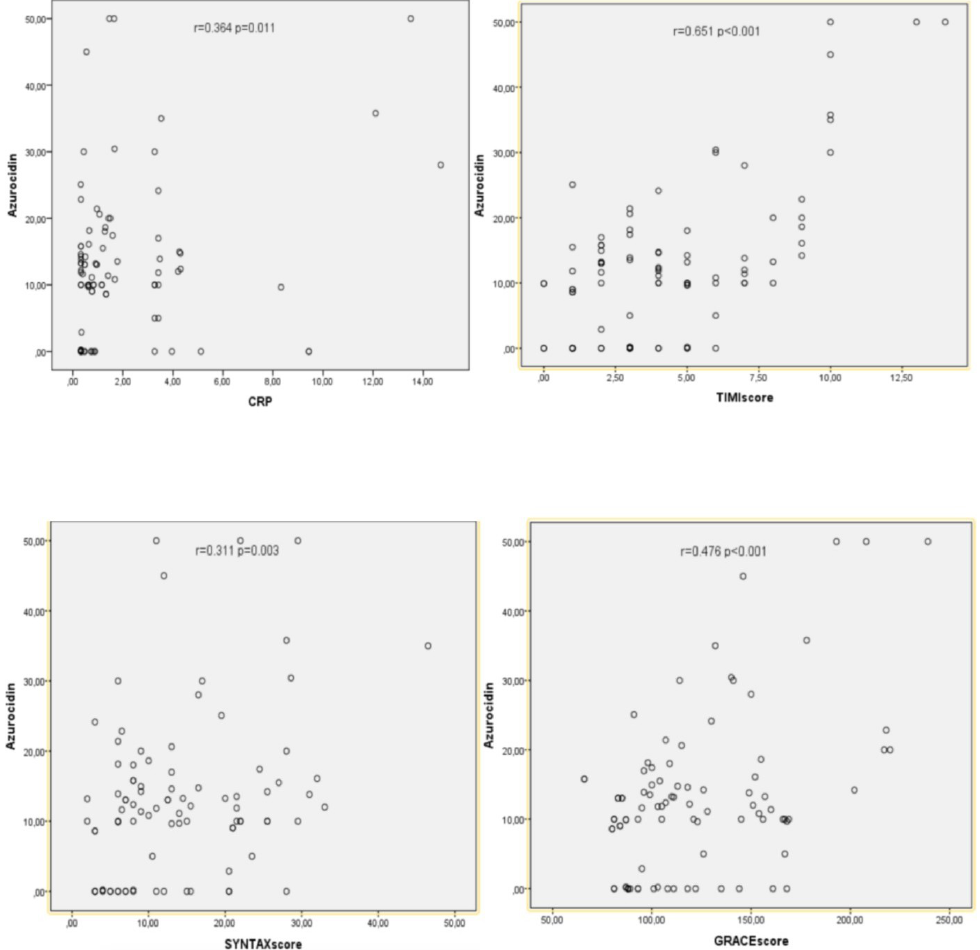
Figure 2. Scatter plots showing the significant correlation between azurocidin levels and C-reactive protein (CRP), thrombolysis in myocardial infarction (TIMI) score, synergy between percutaneous coronary intervention with TAXUS and cardiac surgery (SYNTAX) score and global registry of acute coronary events (GRACE) score. The analysis included 76 patients and correlations were tested with Spearman’s rank correlation coefficient analysis. r : correlation coefficient, p < 0.01.